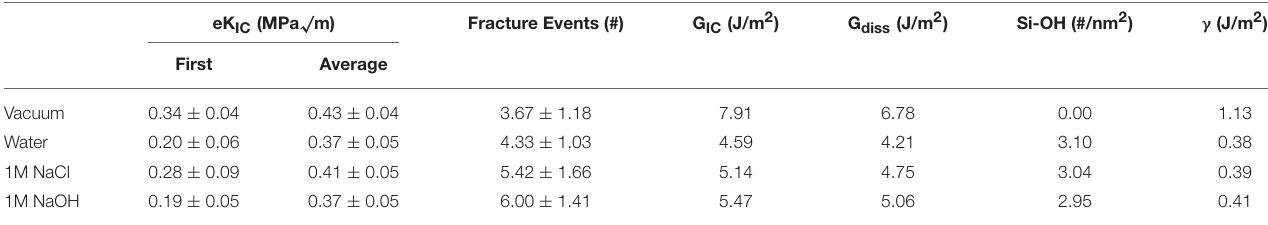
TABLE 2 | Fracture properties of silica in four different environmental conditions (vacuum, water, 1M NaCl, 1M NaOH) as the average and standard deviation of twelve unique simulations.